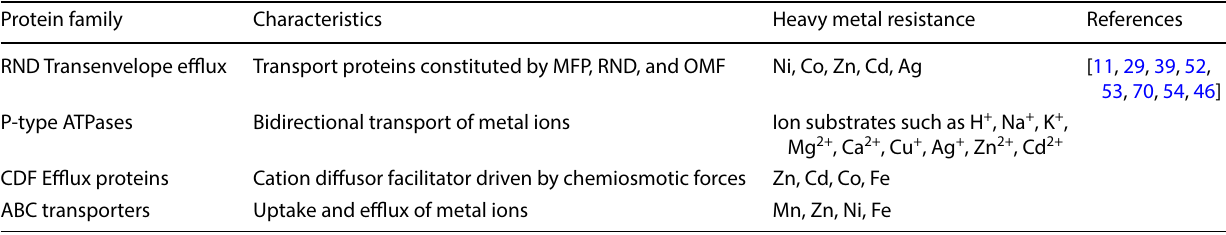
Table 3 Protein superfamilies that contribute to heavy metal resistance in microorganisms